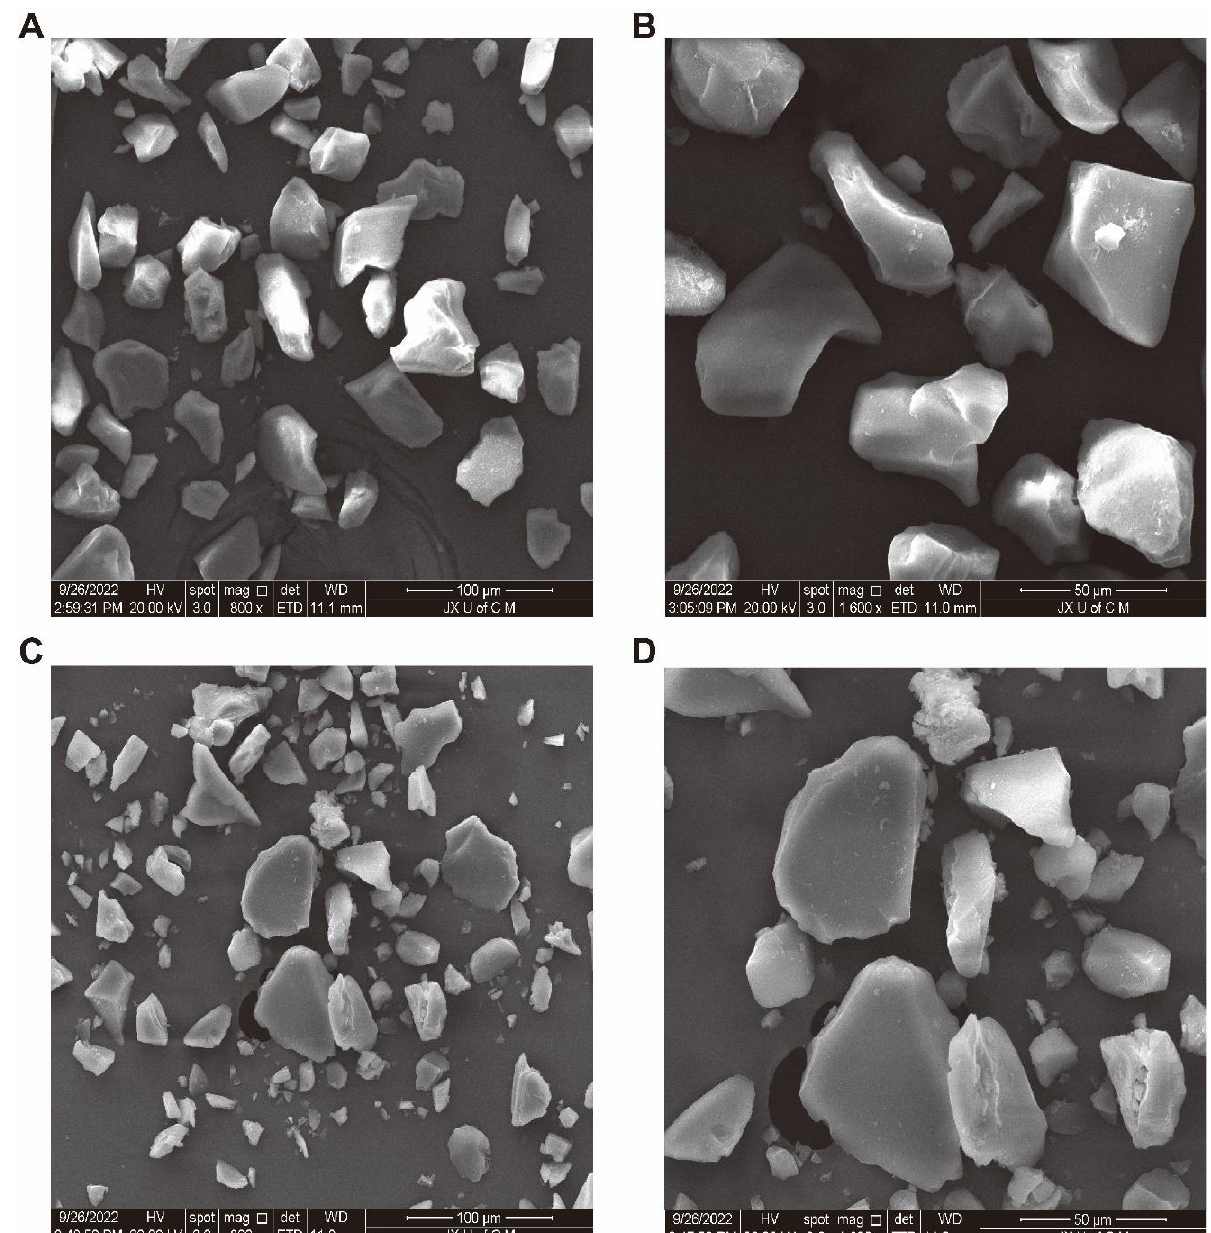
Figure 2. SEM patterns of MIPS at 800x (A) and 1600x ( B ), and NIPS at 800x (C) and 1600x ( D ).